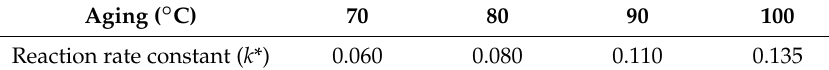
Table 5. Reaction rate constant ( k* ) depending on aging temperature.